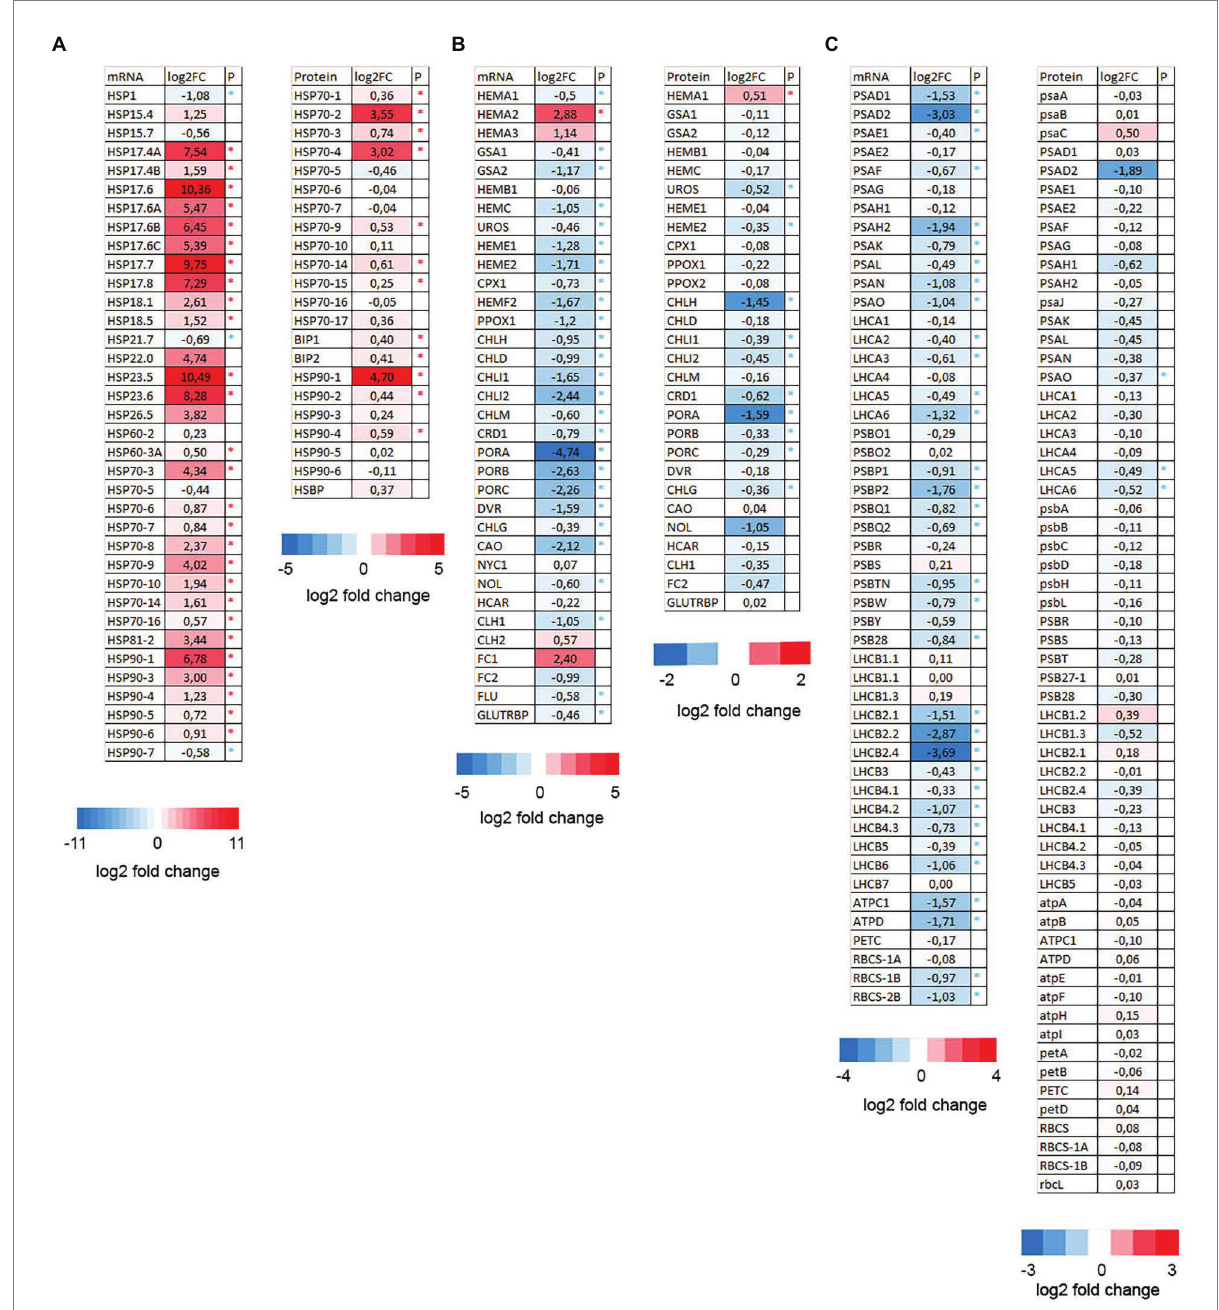
FIGURE 4 Heat maps showing the expression pattern of HSPs (A) , chlorophyll metabolism (B) , and photosynthesis-related genes (C) in Arabidopsis thaliana . Log 2 fold changes in the mRNA (from RNA-seq experiment) and proteins (LC–MS/MS analysis) in diethyl ether treated plants compared to controls (asterisk denote significant differences at p < 0.05, n =